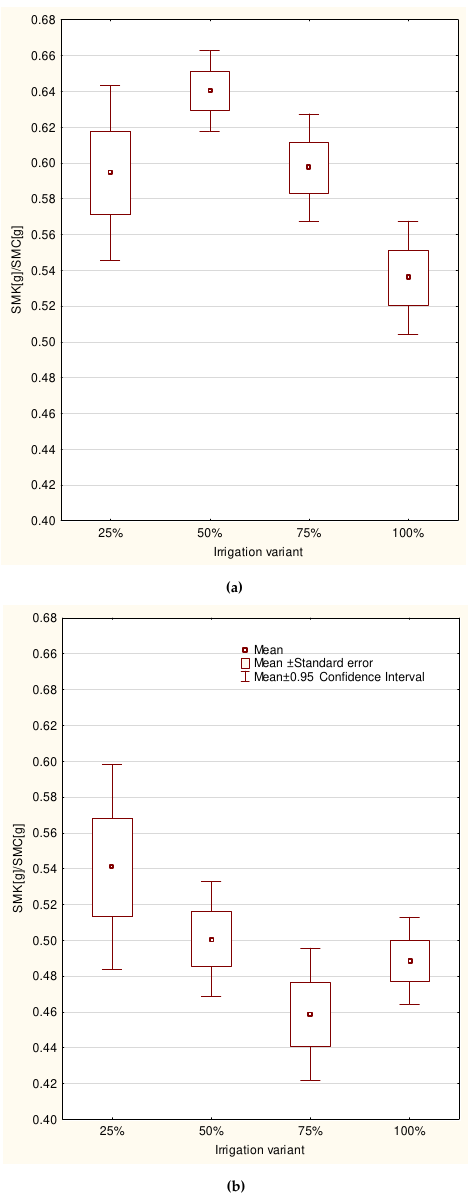
Figure 3. Mean rate of dry root mass (SMK) to dry plant mass (SMC) of the sessile oak in years’ 2015 ( a ) and 2016 ( b ) for each variant including standard errors and confidence intervals.